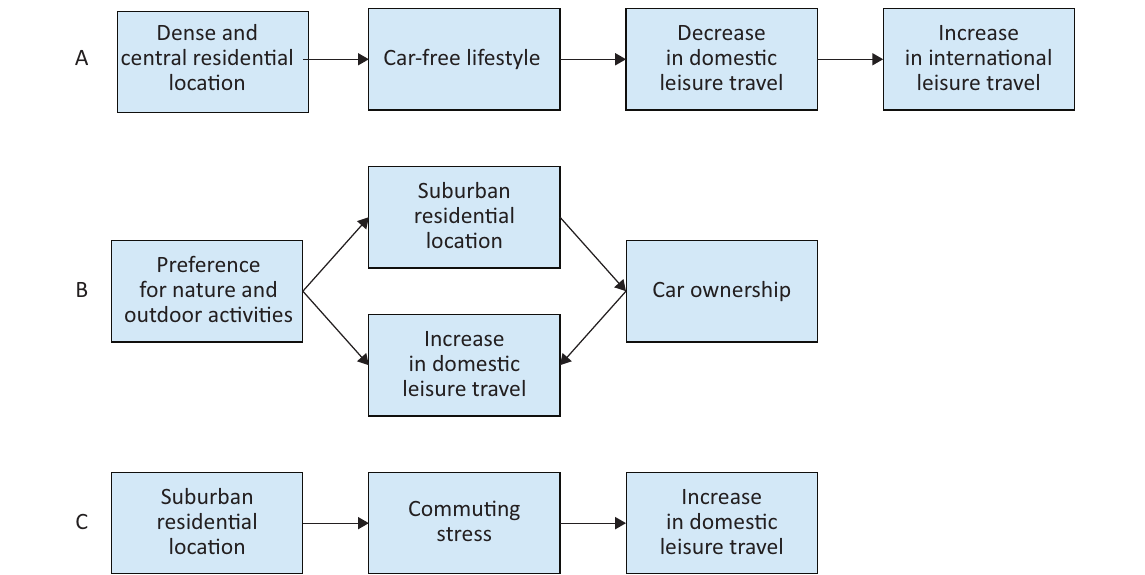
Figure 2. Connections between residential location characteristics and long‐distance leisure travel detected in the study. (2020a), the interviewees in this study were satisfied with their dwellings and/or neighborhood, which sug‐ gests a high strength of residential self‐selection tenden‐ cies in Reykjavik. The age range and good material situ‐ ation of the respondents might have influenced this as they have a stable living situation, most of them being the owners of their dwellings and therefore probably invested time into choosing a location suitable to their lifestyle, preferences, and needs. This kind of residen‐ tial self‐selection related to nature/outdoors preferences might thus prevent existing examples of compensatory travel behavior from showing in aggregate